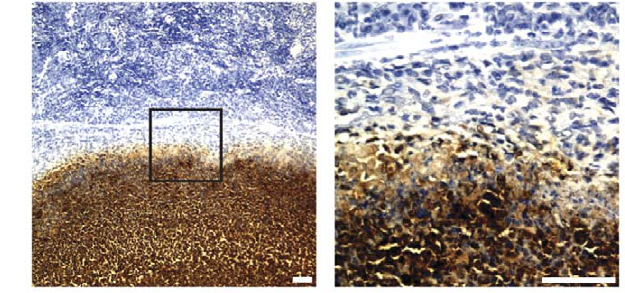
Figure 4. Detection of CPS within a splenic abscess by IHC. Organs were harvested from control BALB/c mice (Fig. 3) that were infected with B. pseudomallei strain 1026b. A tissue section from a spleen that contained multiple large abscesses is shown (left panel). Location of CPS was identified by HRP-labeled mAb 3C5 (brown). Box within the panel on the left indicates the boundary of an abscess and surrounding normal splenic tissue (tissue within box is magnified in right panel). White scale bars indicate 50 m m.